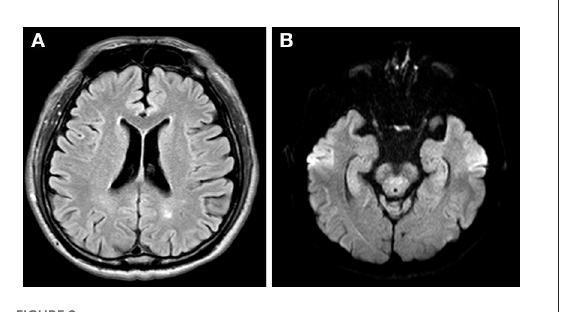
FIGURE1 (A) This patient demonstrated puffy eyelid along with decreased lid height when his orbicularis oris contracted (B) Lid height was restored when his orbicularis oris